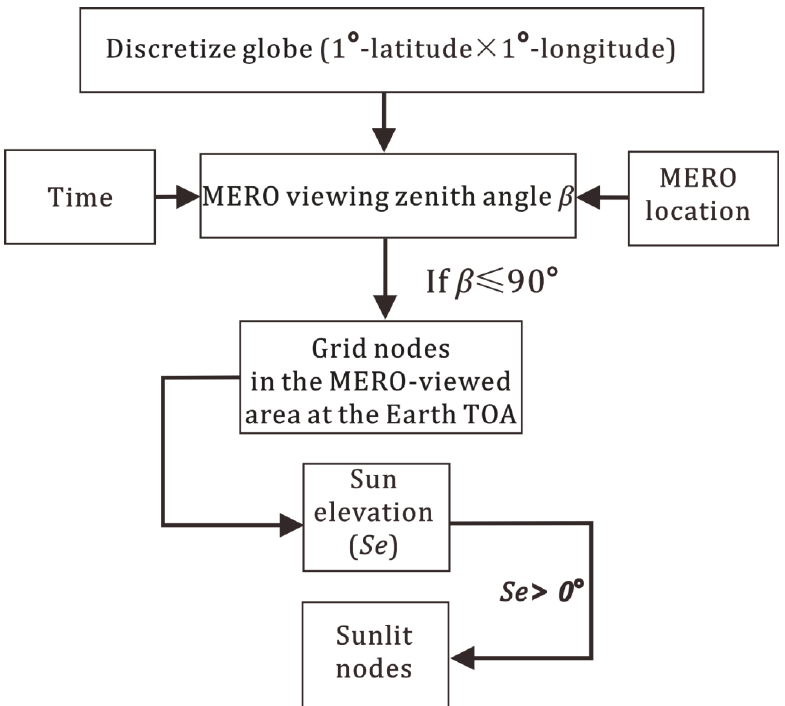
Figure 3. Flowchart to derive the temporal-spatial distribution of the MERO-viewed area at the Earth TOA.